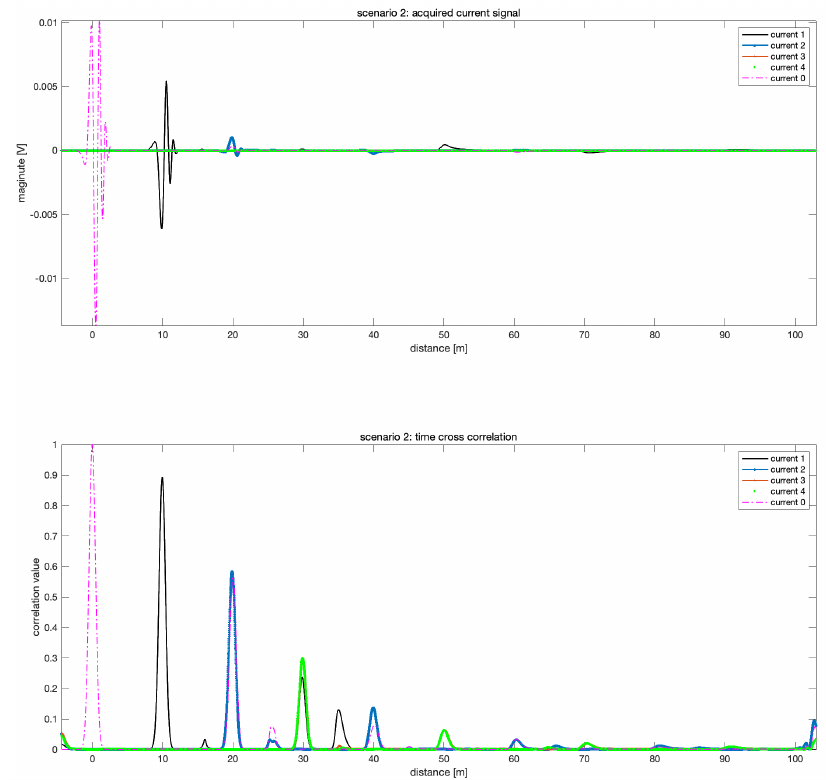
Figure 14. Fault localization results: scenario